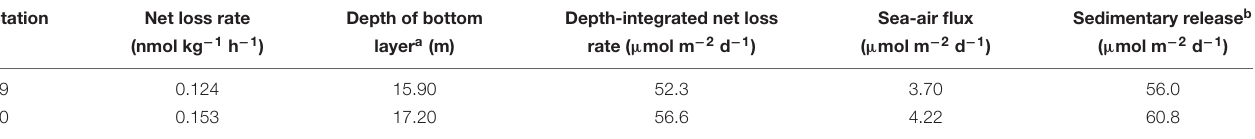
TABLE 2 | Sources and sinks of CH 4 at stations 29 and